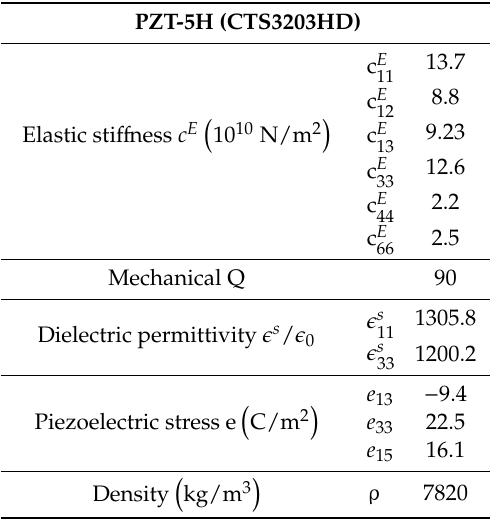
Table 2. Material properties of the PZT-5H used in the FEA simulation.